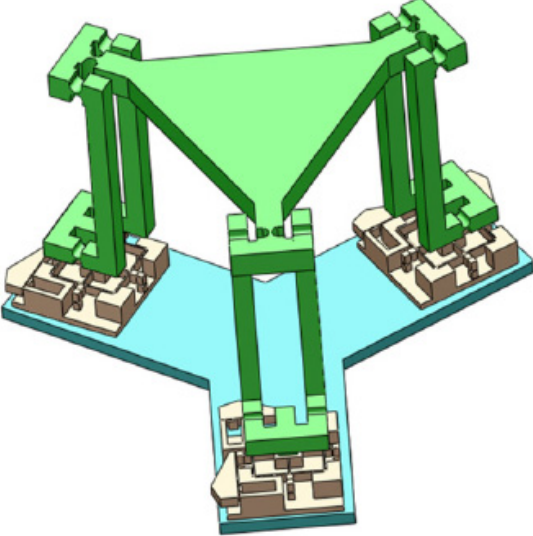
Figure 5. Typically example of a spatial serial compliant stage (Liang et al., 2011). Three legs forms a parallel compliant mecha- nism performing motion in z, θ x, θ y, θ z. The legs are supported by parallel 2DoF compliant mechanisms. Both parallel mechanisms in serie forms the spatial serial compliant stage.